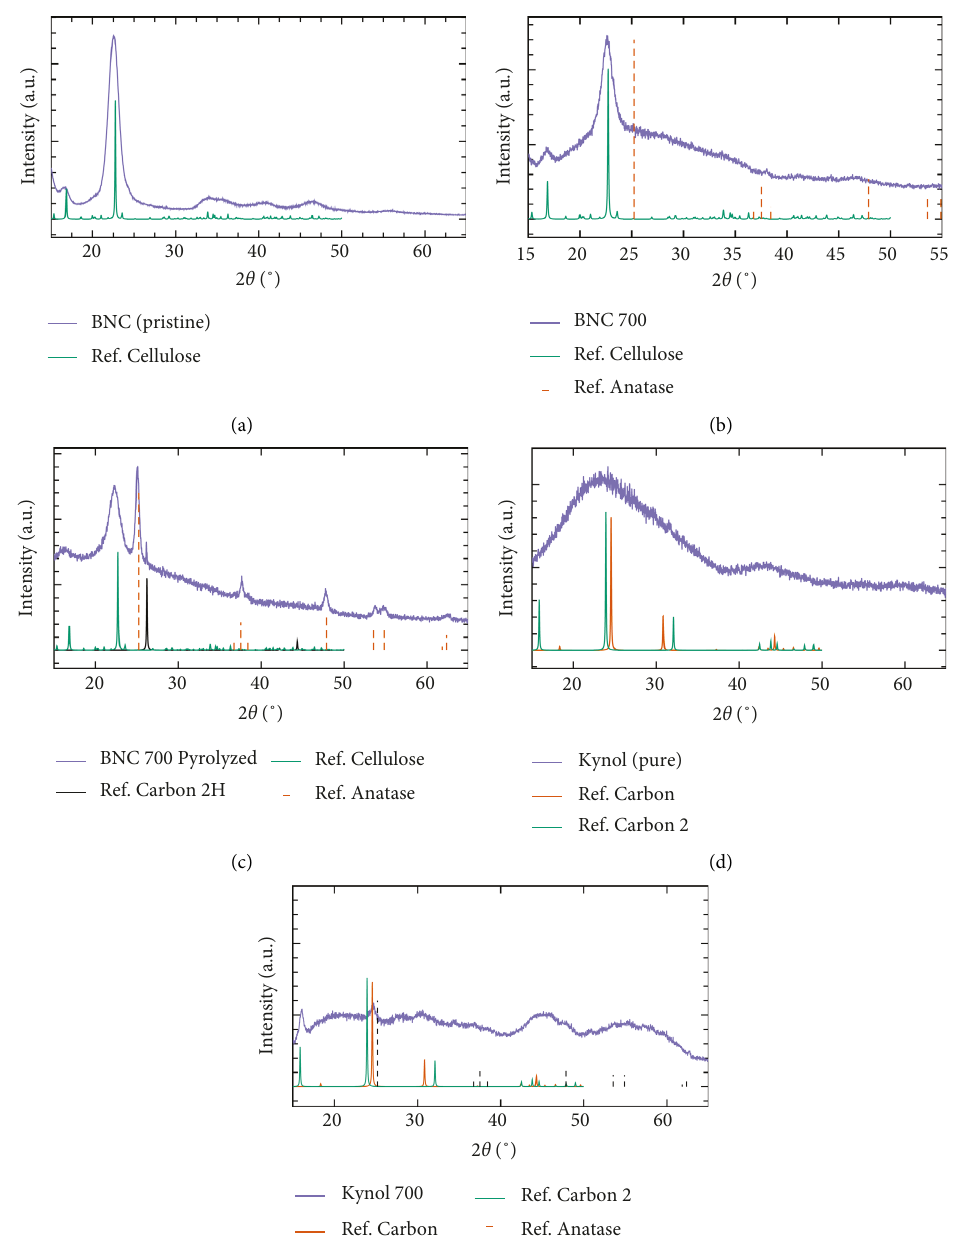
Figure 7: XRD patterns of (a) pristine BNC, (b) TiO 2 ALD-coated BNC, (c) ALD-coated BNC sample after pyrolysis, (d) pure Kynol, and (e) the TiO 2 ALD-coated